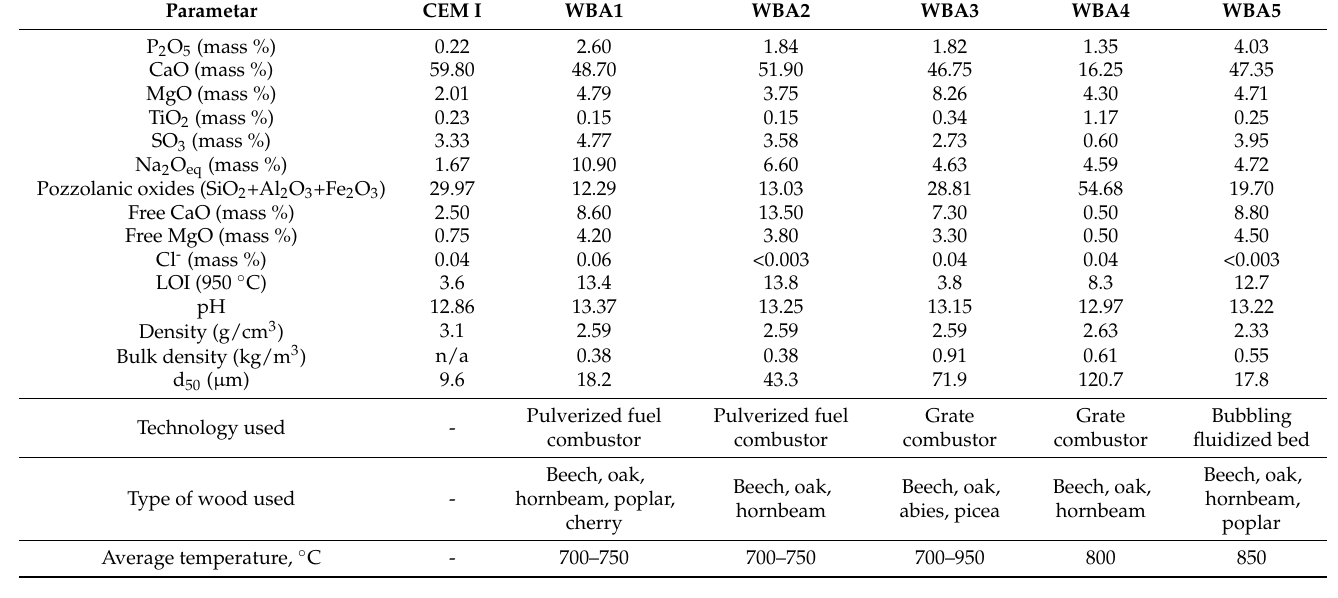
Table 1. Chemical and physical properties of the wood biomass ash (WBA) samples and cement.